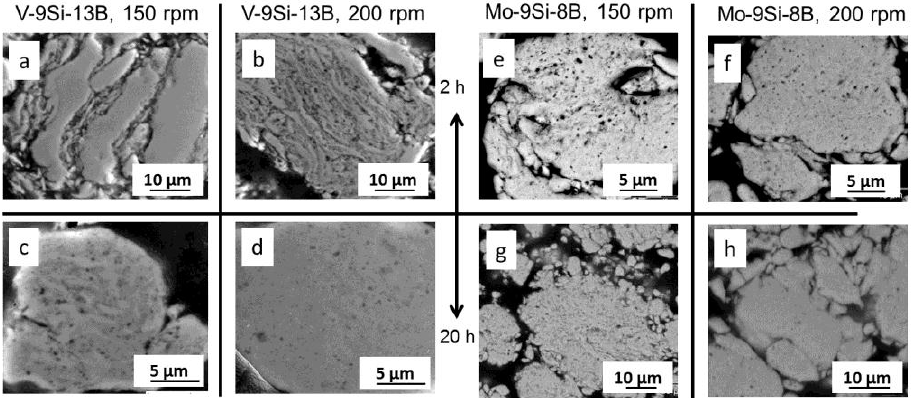
Figure 3. Microstructural evolution of ( a – d ) V-9Si-13B powders and ( e – h ) Mo-9Si-8B powders during mechanical alloy (MA) using steel balls and vials.